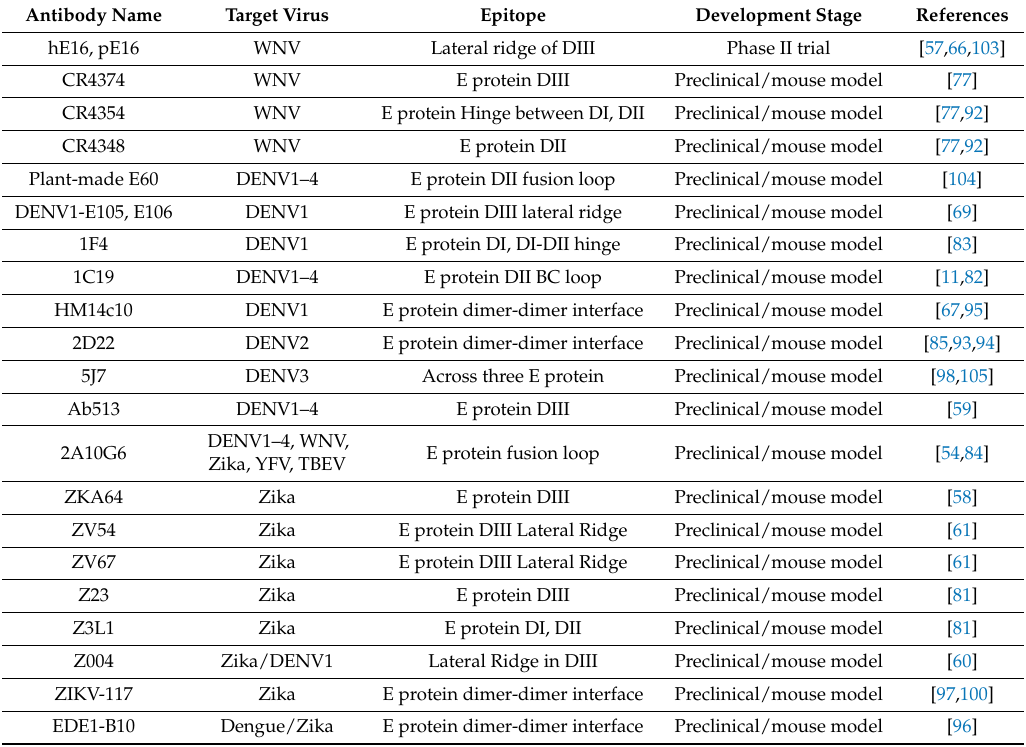
Table 1. Flavivirus antibodies with therapeutic